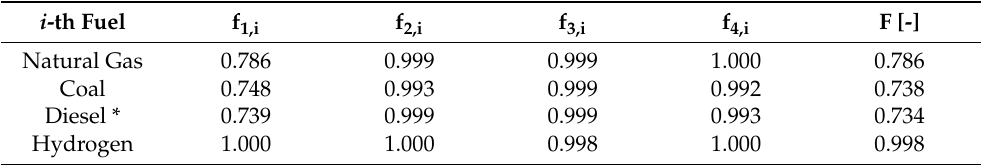
Table 4. Correction factors related to the magnitude of the emitted pollutants normalized by the available combustion